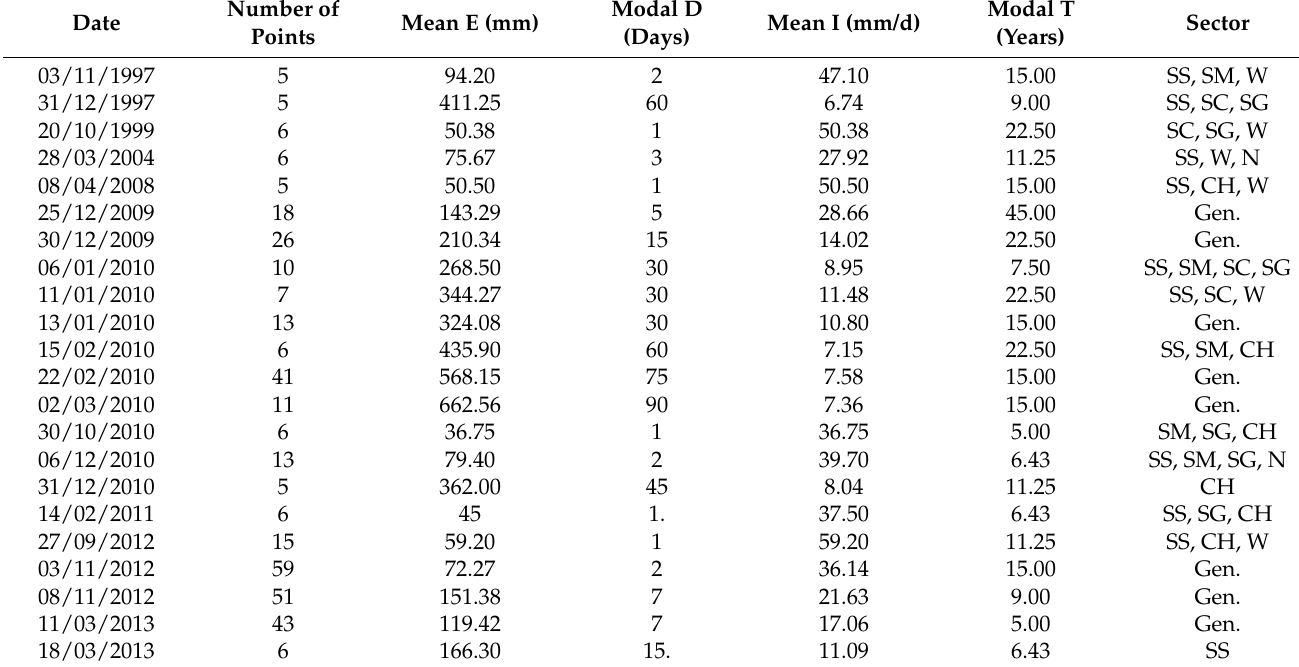
Table 4. Main rainfall events associated to incidences. Sector: SS, Sierra Sur; SM, Sierra M á gina; SC, Sierra Cazorla; SG, Sierra Segura; J, Ja é n sector; CH, Central Hills; W, Western sector; N, Northern sector; Gen.,